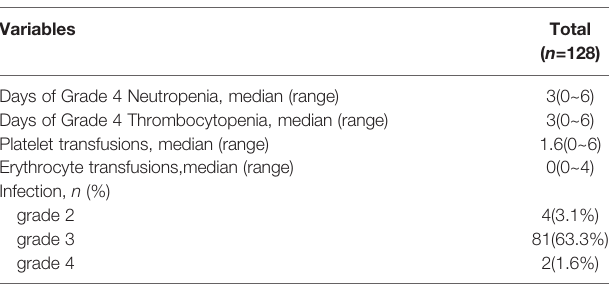
TABLE 3 | Common toxicities.